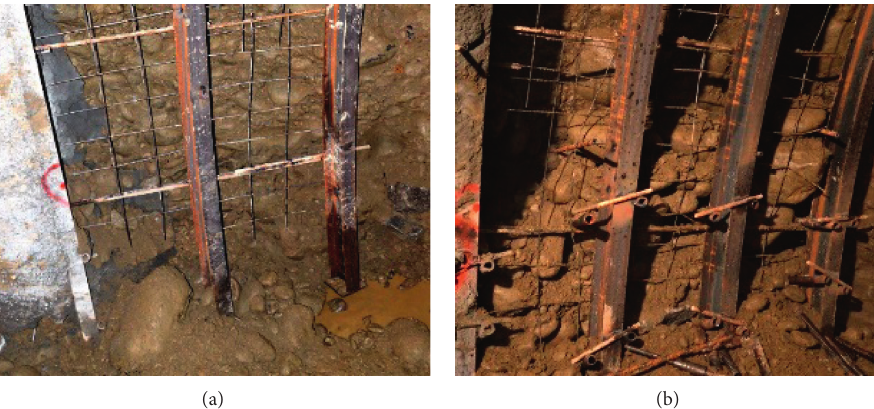
Figure 6: Comparison of (a) before and (b) after insertion of feet reinforcement bolts. (a) Before the feet reinforcement bolts are penetrated. (b) After the feet reinforcement bolts are penetrated.